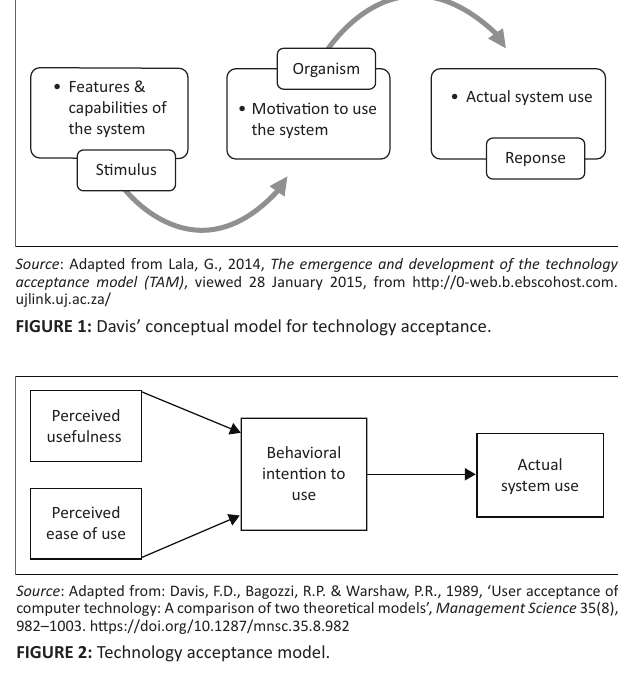
FIGURE 2: Technology acceptance